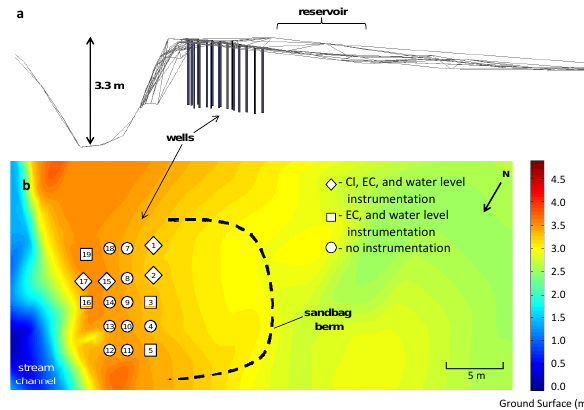
Fig. 1. Side view (a) and plan view (b) of site topography (meters above datum) and well